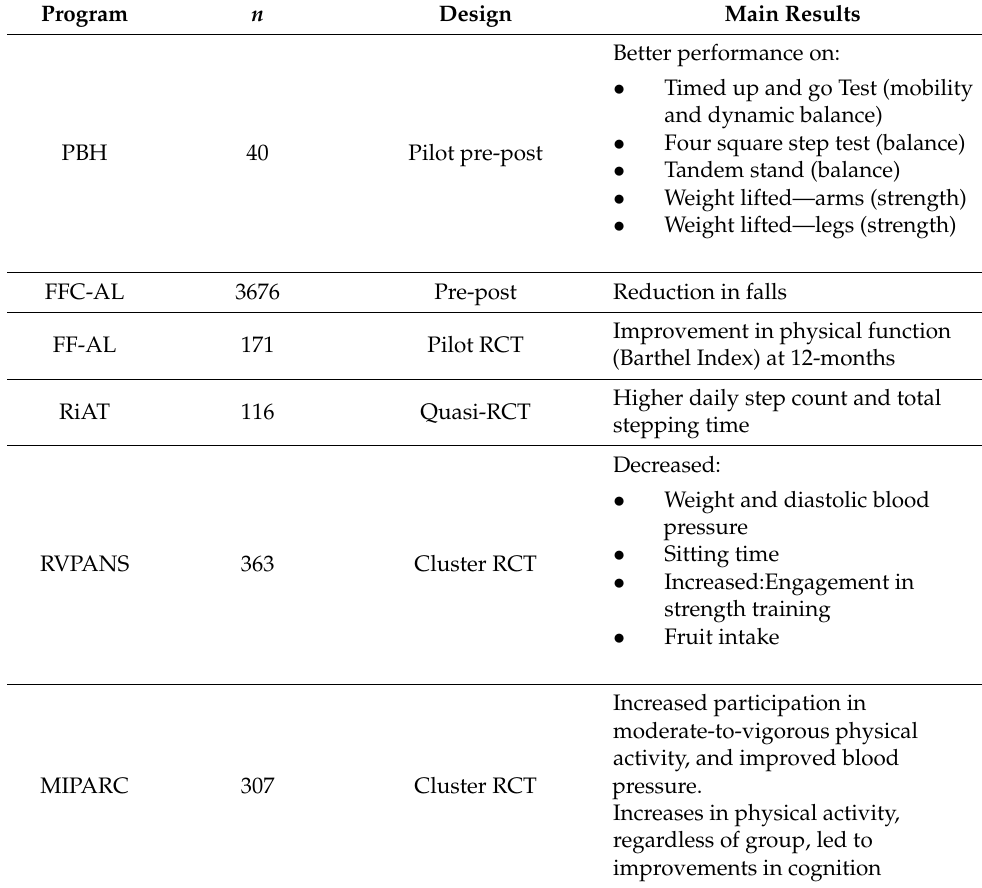
Table 2. Summary of results of included